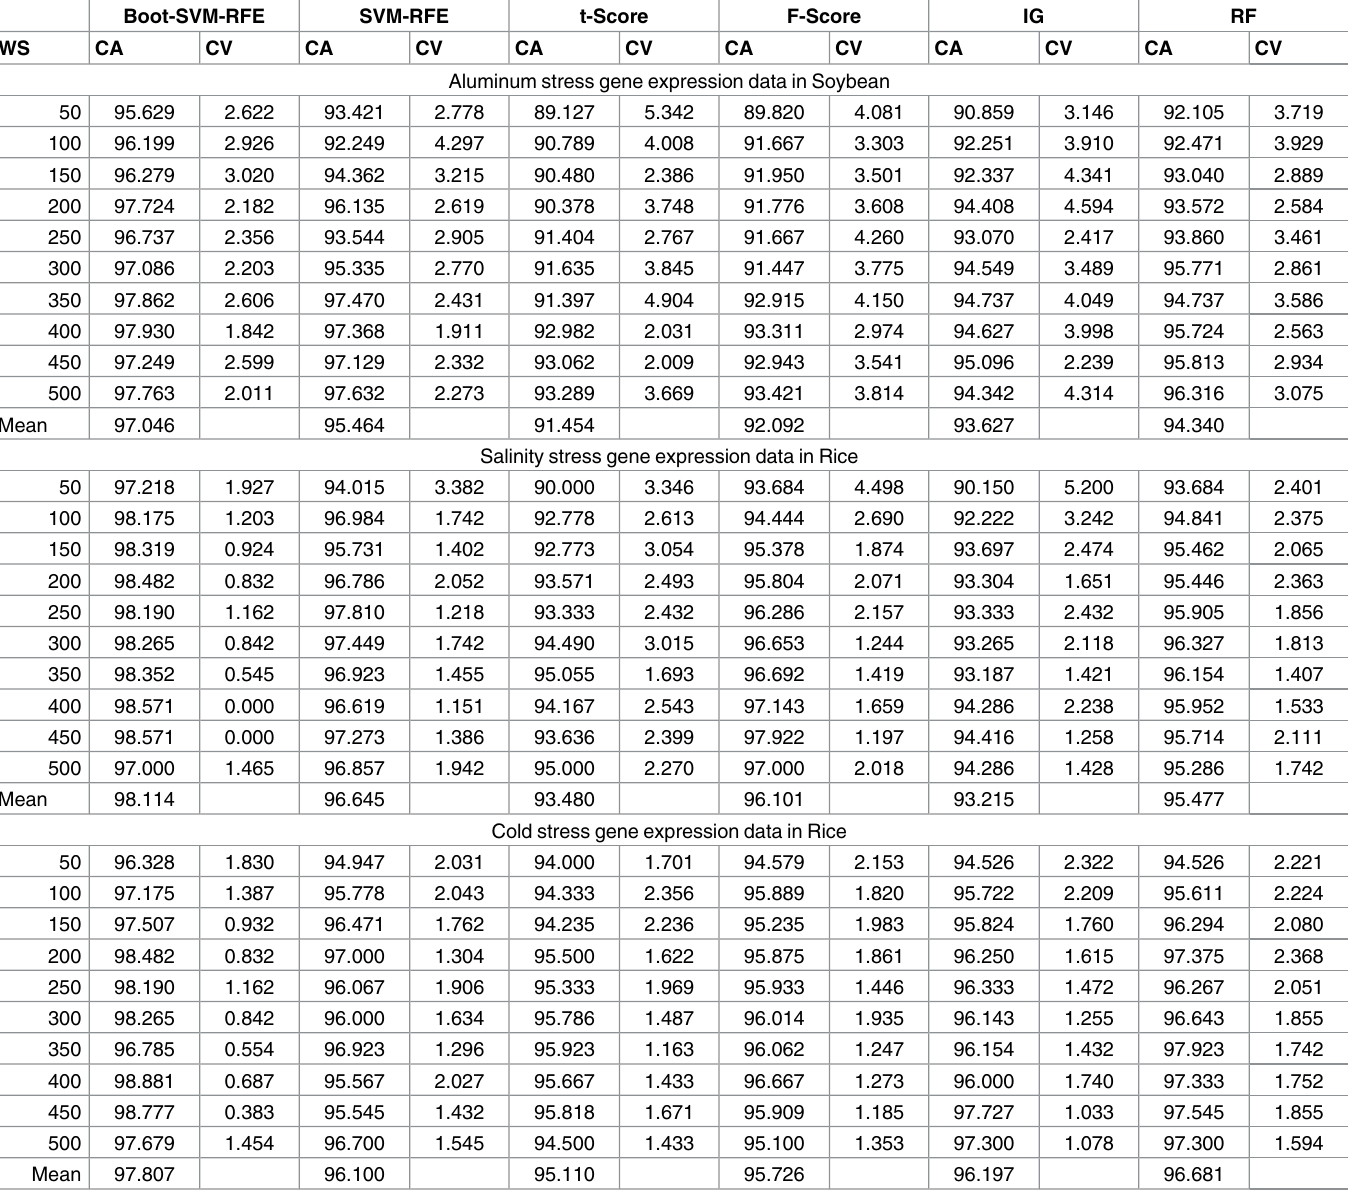
Table 3. Comparison of Boot-SVM-RFE with other competitive algorithms for different sliding window